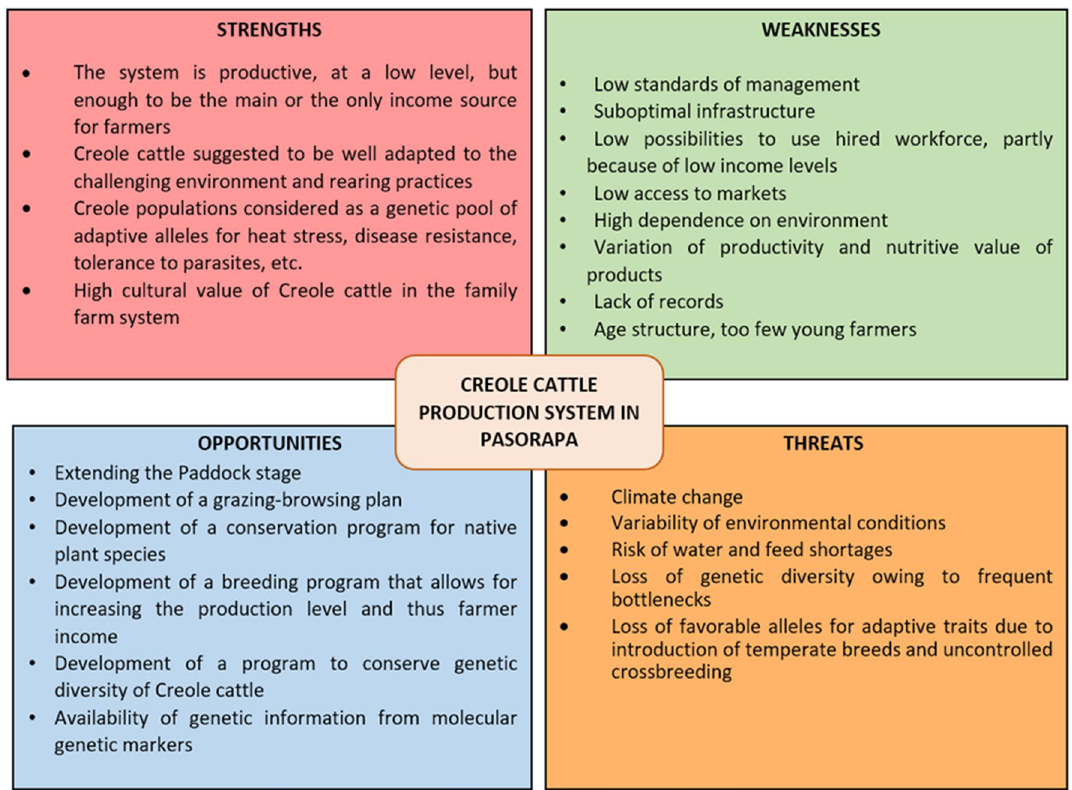
Fig. 4 Results of SWOT analysis on the Creole cattle production system in Pasorapa,